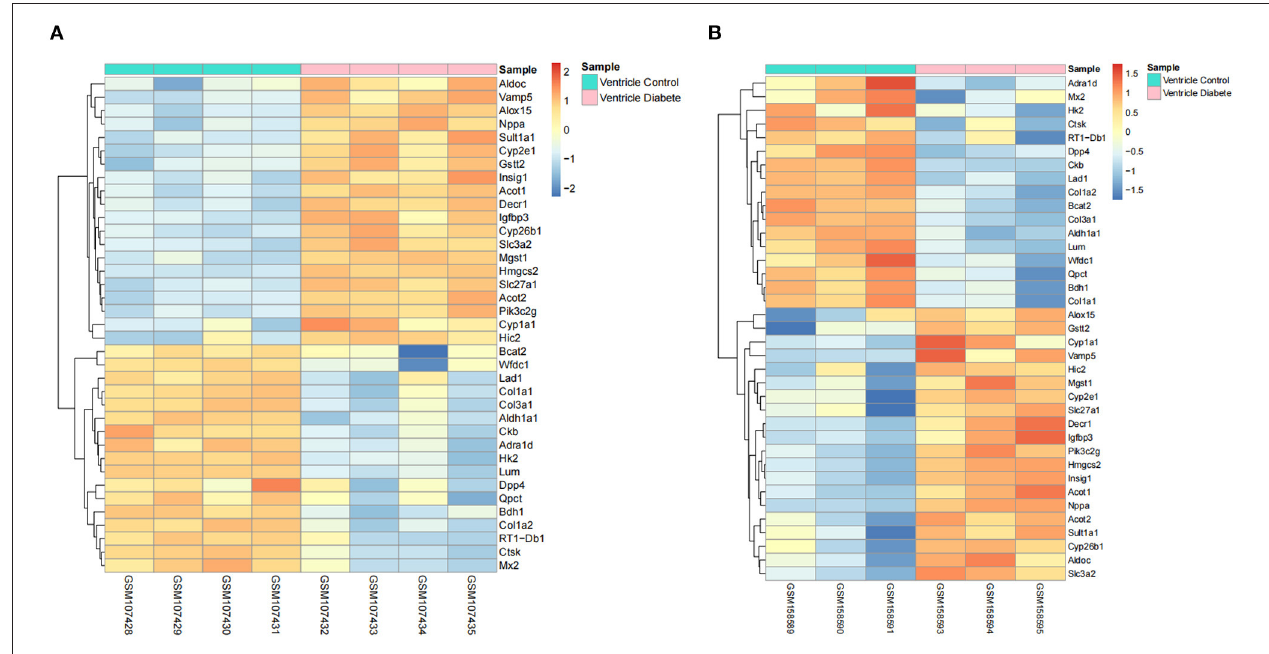
FIGURE 2 | Heatmaps of common DEGs between normal and diabetic heart samples in datasets GSE4745 and GSE6880 (20 up-regulated DEGs and 17 down-regulated DEGs). (A) Heatmap of common DEGs in dataset GSE4745. (B) Heatmap of common DEGs in dataset GSE6880. The color of the heatmap from blue to red shows the gene expression from low to high. Red indicates upregulated gene expressions. Blue indicates downregulated gene expressions. Pink represents the samples of diabetic group. Turquoise represents the samples of control